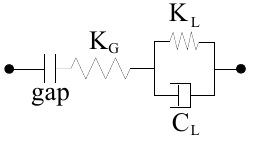
Figure 1. Impact element composed of a gap element and a Kelvin-Voigt element.